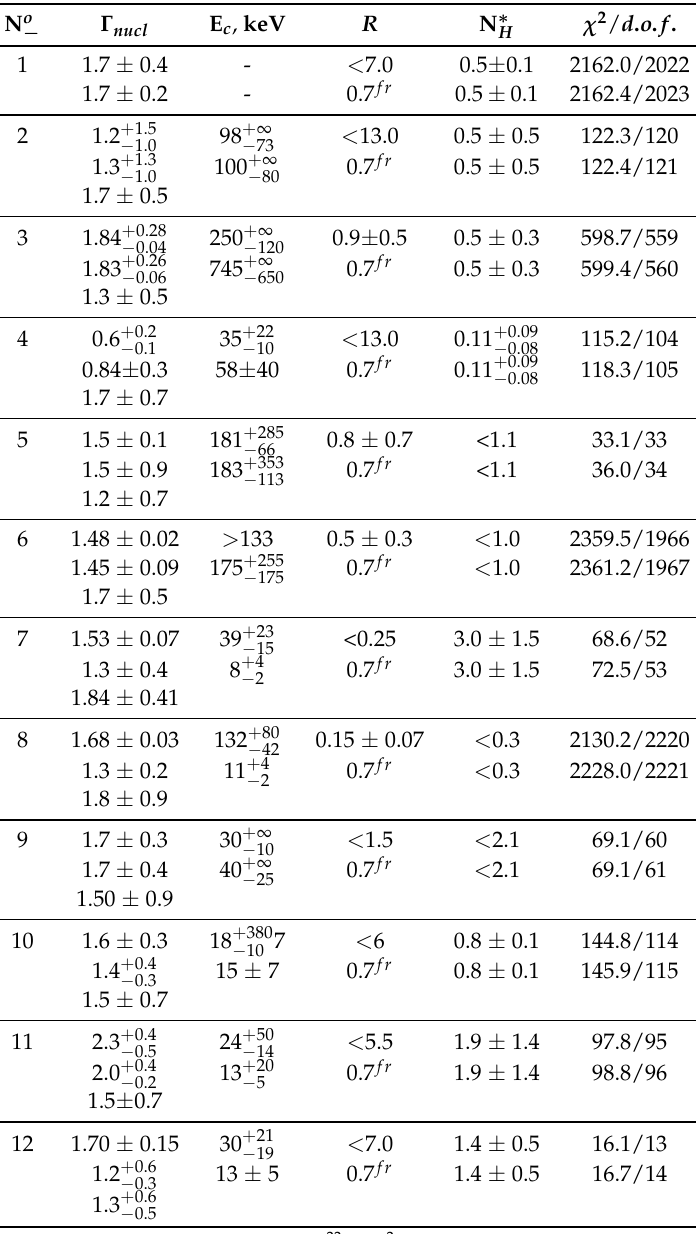
Table 1. Hard X-ray continuum parameters with marginal errors (90% probability) for 3C 111. First lines in each cell include nuclear continuum parameters estimated with the frozen value of the jet base emission index Γ fr :index Γ nucl , exponential cutoff energy E c and reflection coefficient R of the nuclear emission. The second lines present analogous fit with frozen Γ fr and frozen reflection coefficient R fr = 0.7 as it was obtained by Reference de Jong et al. [25]. The lower lines of the first column show the jet emission indexes Γ fit (free) from the independent power-law fit of the spectral tail for E > 80 keV. First column: observational period; second to fifths columns: photon index, high-energy cut-off and reflection of primary nuclear emission; fifth column: absorbing column density excess in comparison with the Galactic absorption; sixth column: